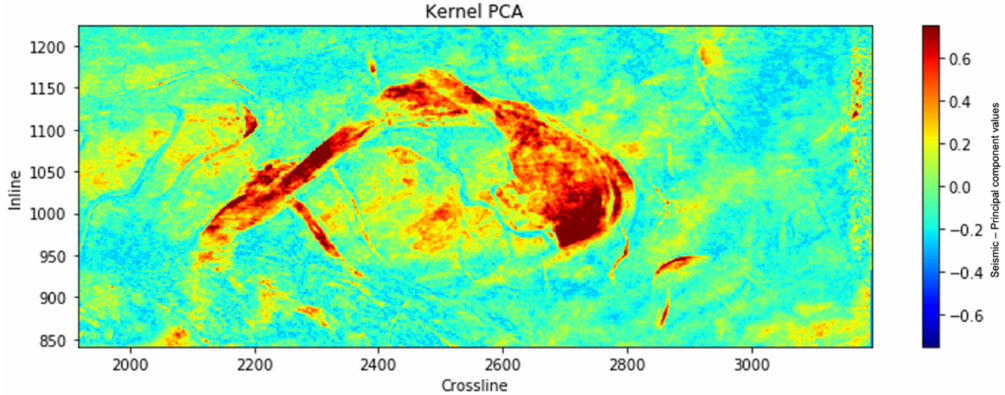
Figure 20. The result of dimensionality reduction using KernelPCA.